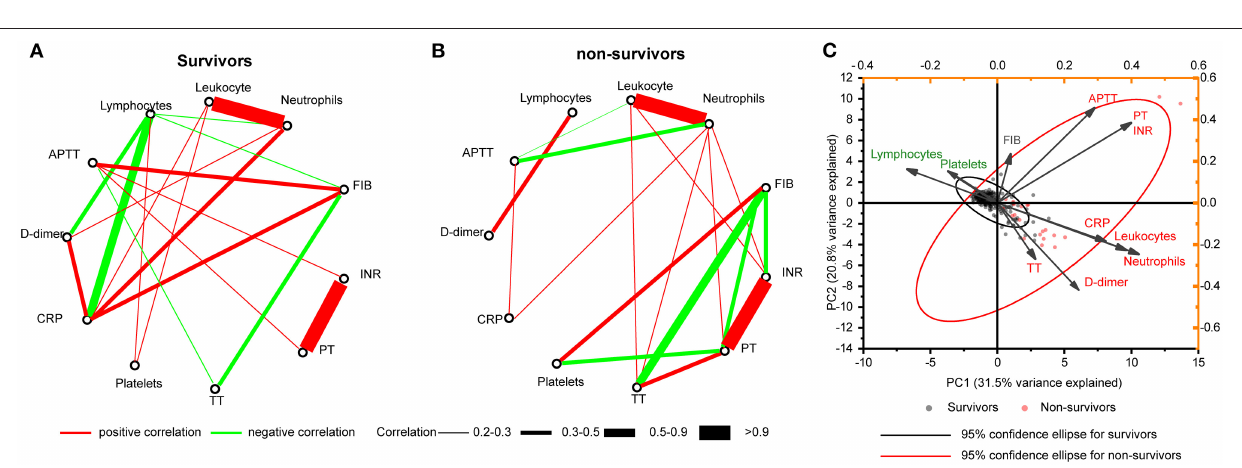
FIGURE 4 | Correlation networks for hematologic indices. Networks showed different profiles of correlations in COVID-19 survivors (A) and non-survivors (B) , on admission. (C) PCA biplot of hematologic indices on admission. Individuals are shown as dots and colored by outcomes (survivors and non-survivors). Indices showed as lines with arrows and colored by positive or negative contribution to PC1. The configuration of indices in biplot represented the relationship between variables and principal components. PCA, principal component